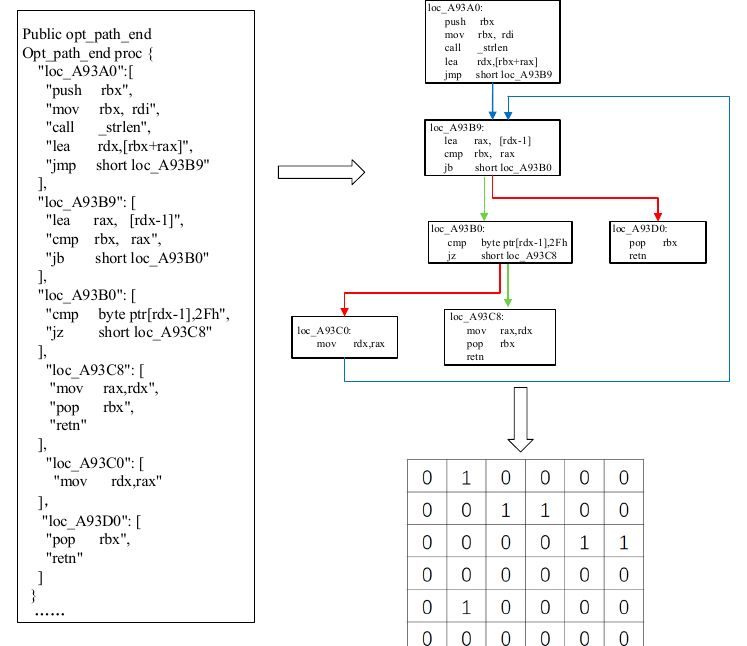
Figure 7. Schematic of basic block adjacency matrix establishment. The assembly segment is selected from function “Opt_path_end” in the OpenSSL project as an example to show a detail matrix of the establishment process.